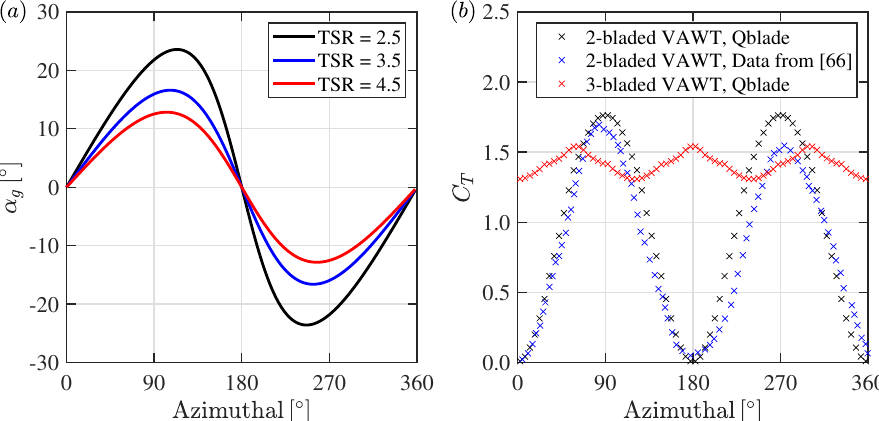
Figure 6. ( a ) Oscillations of α g at λ = 2.5,3.5 and 4.5 during one rotation cycle for one VAWT blade. Turbine dimensions are those used in [66]. ( b ) C T versus rotor azimuthal angle at λ = 3.5 for a two- bladed VAWT, simulated with Qblade and experimental data from [66] in black and blue markers, respectively. The red markers show the simulated C T , with Qblade, for a three-bladed